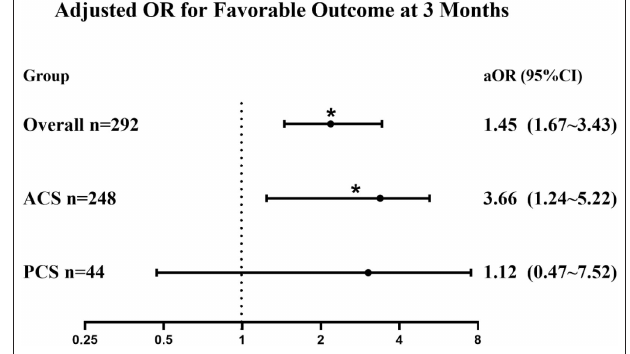
FIGURE 2 | Forest plot of adjusted OR for the association between tirofiban administration and favorable outcomes (mRS 0–2) in patients with posterior circulation stroke (PCS) and anterior circulation stroke (ACS). Adjusted for age, ASPECTS/pc-ASPECTS, tirofiban, baseline NIHSS, glucose, TOAST classification, and location (posterior or anterior circulation). aOR, adjusted odds ratio; mRS, modified Rankin Scale; ASPECTS, Alberta Stroke Program Early Computed Tomography Score; pc-ASPECTS, posterior circulation ASPECTS; NIHSS, National Institutes of Health Stroke Scale; TOAST, Trial of ORG 10172 in Acute Stroke Treatment. * p <